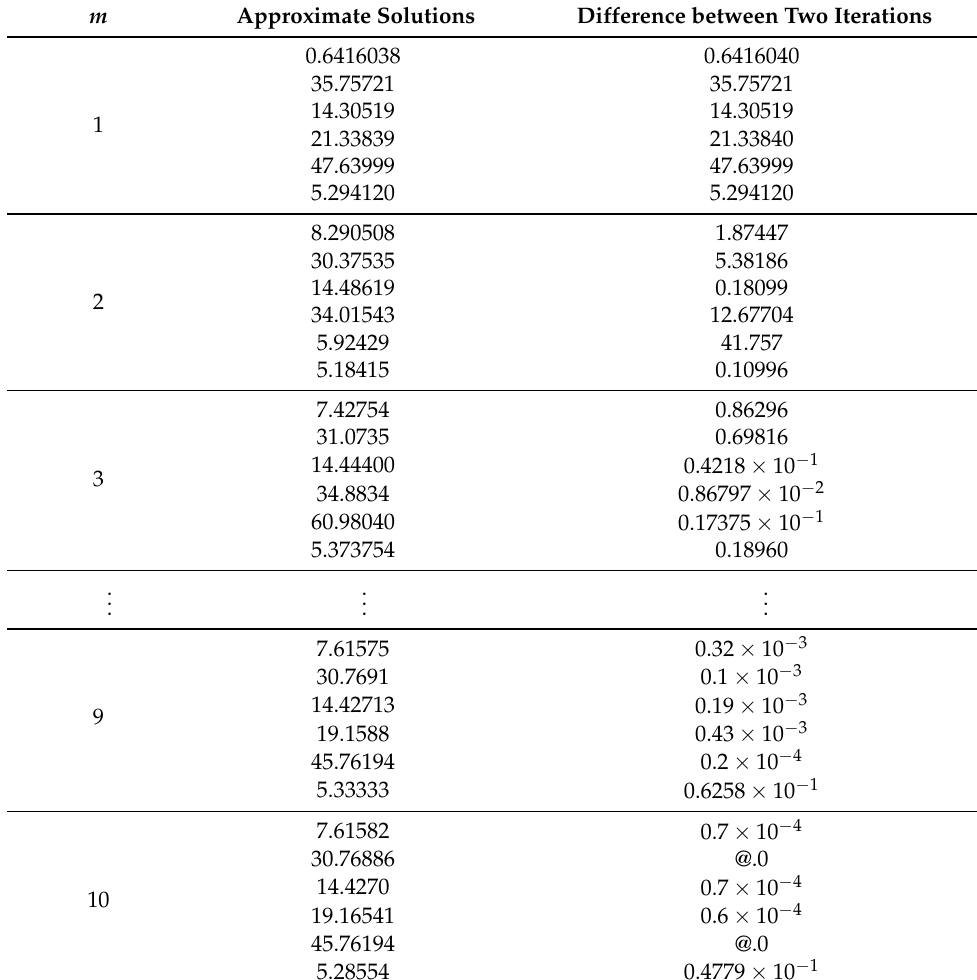
Table 5. Numerical results based on the DSA and using the CESTAC method for t = 0.2, ρ = 0.9 and ¯ h = −